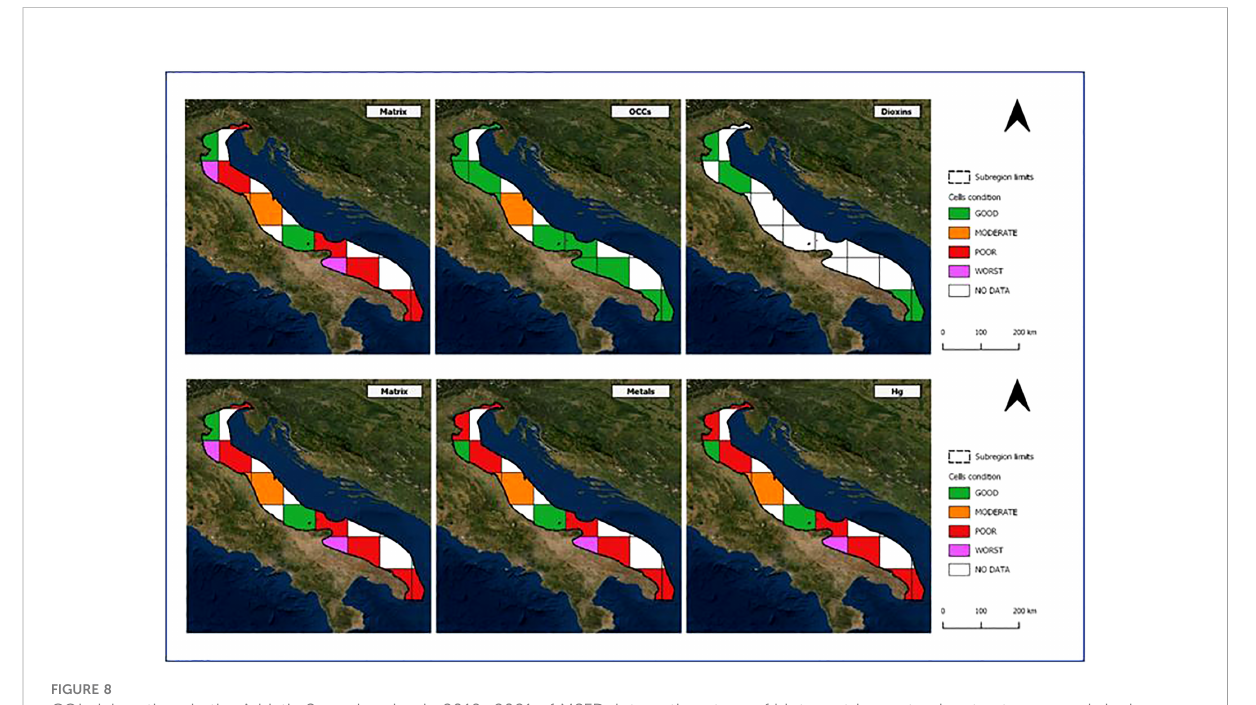
FIGURE 8 CQI elaborations in the Adriatic Sea subregion in 2019 – 2021 of MSFD. Integration steps of biota matrix, contaminant category, and single substance.